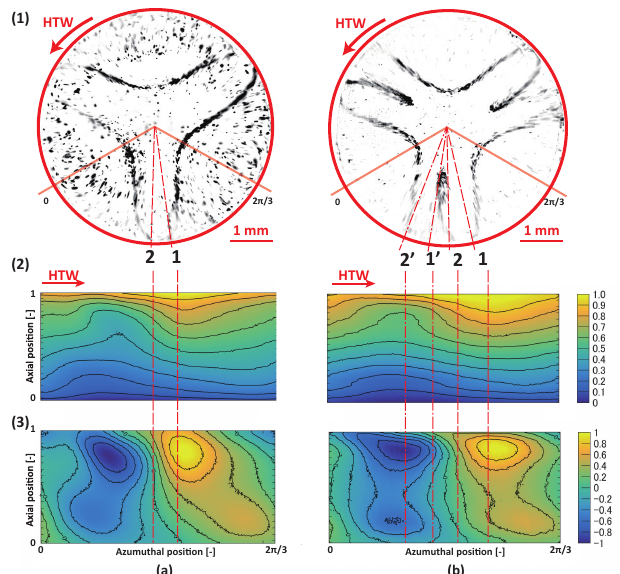
Figure 3. Correlation between PAS and surface temperatures for ( a ) SL1-PAS under Ma = 4.7 × 10 4 and ( b ) SL2-PAS under Ma = 5.8 × 10 4 in a liquid bridge of Pr = 28.6, Γ = 0.68 ( R = 2.5mm), and V / V 0 = 1.0 (the same condition as shown in Figure 1): Row ( 1 ) illustrates the top views of the PASs, and rows ( 2 ) and ( 3 ) the absolute temperature and the temperature deviation over the free surface in a range of 0 ≤ θ ≤ 2 π /3 (as defined in row ( 1 )), respectively. Ma is evaluated by applying H for the characteristic length L . (Figure 11 in Toyama et al.